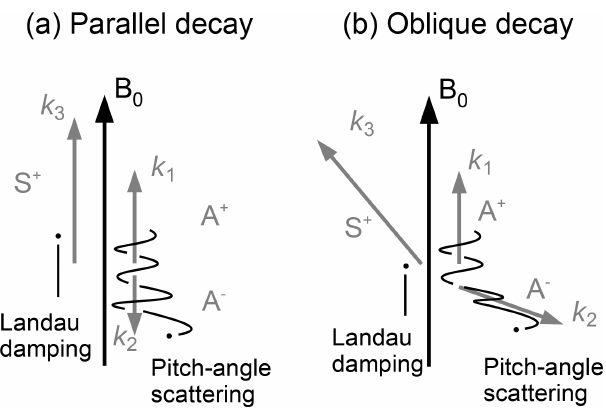
Figure 1. Parametric decay of a parallel-propagating Alfvén wave (“ A + ” with the wavevector k 1 ) into a daughter Alfvén wave (“ A − ” with k 2 ) and a sound wave (“ S + ” with k 3 ) in the parallel decay scenario (a) and the oblique decay scenario (b) . Particle trajectories are marked by solid lines in black.